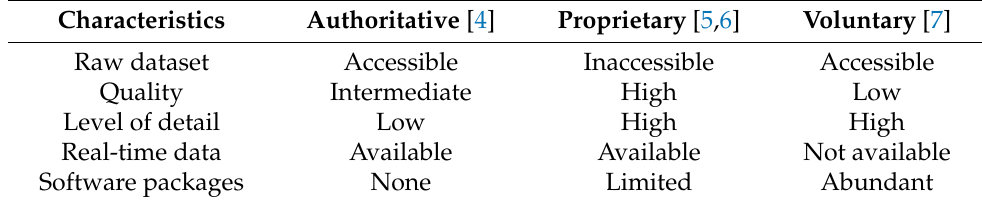
Table 1. Characteristics of authoritative, proprietary, and voluntary road